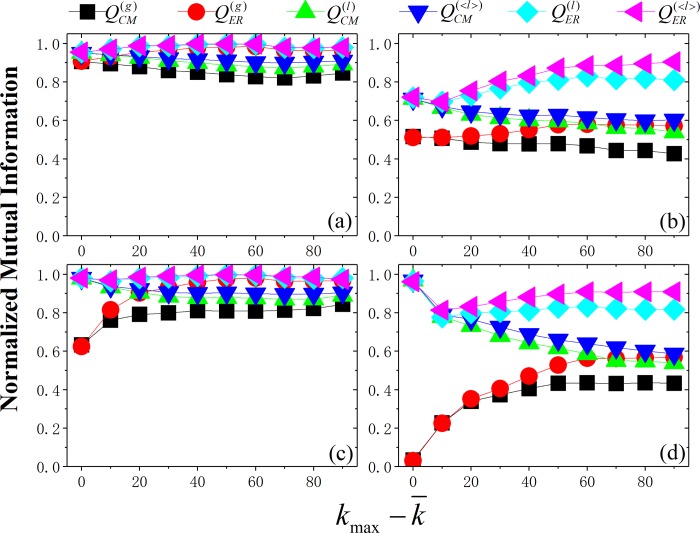
NMI obtained by different modularity as a function of vertex-degree difference (kmax-km) in the NET2 networks.Parameters of networks: (a) N=1000, cmax=150; (b) N=5000, cmax=150; (c) N=1000, cmax=1.5 kmax; (d) N=5000, cmax=1.5 kmax (see Table 1 for details of network parameters).